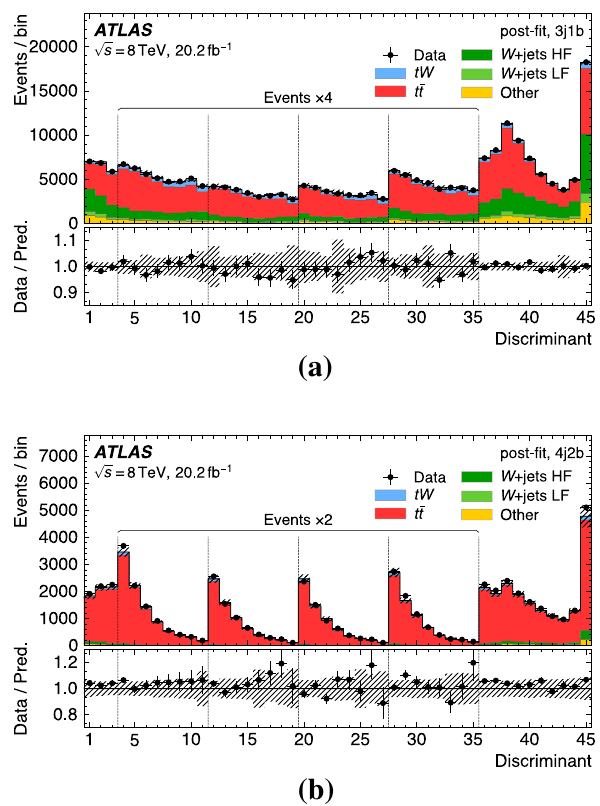
Fig. 8 Post-fit distributions of the discriminant in the a signal region and b validation region. Small backgrounds are subsumed under ‘Other’. The dashed uncertainty band includes statistical and system- atic uncertainties. The lower panels show the ratio of the observed and the predicted number of events in each bin. The first three bins and the last ten bins correspond directly to (non-uniform) bins of m ( W H ) . In between are four blocks of eight bins, corresponding to the NN output in slices of m ( W H ) . Inside each of the blocks, the numbers of events are scaled by a factor of four (factor of two in 4j2b) for better